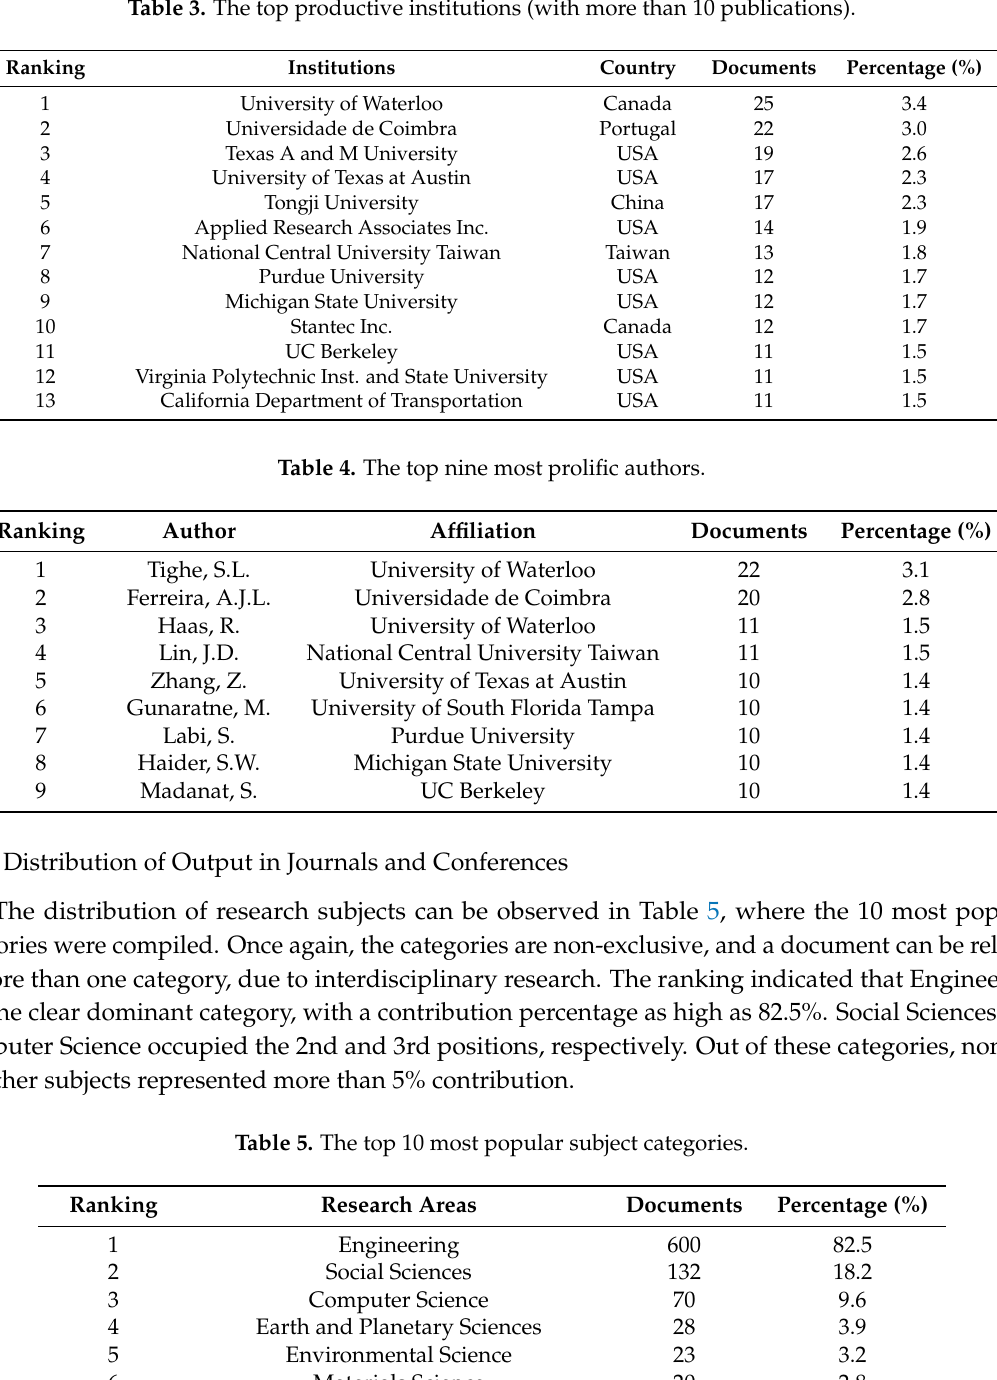
Table 3. The top productive institutions (with more than 10 publications).